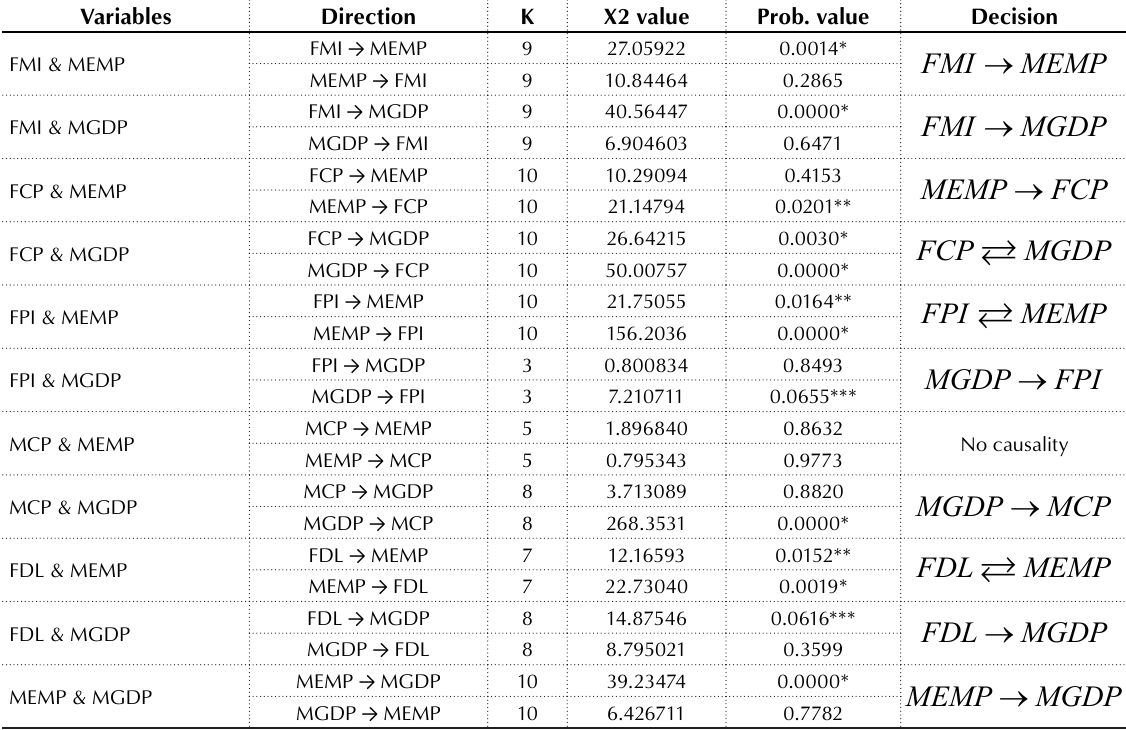
Table 2. Long run-relationship using MEMP as dependent variable